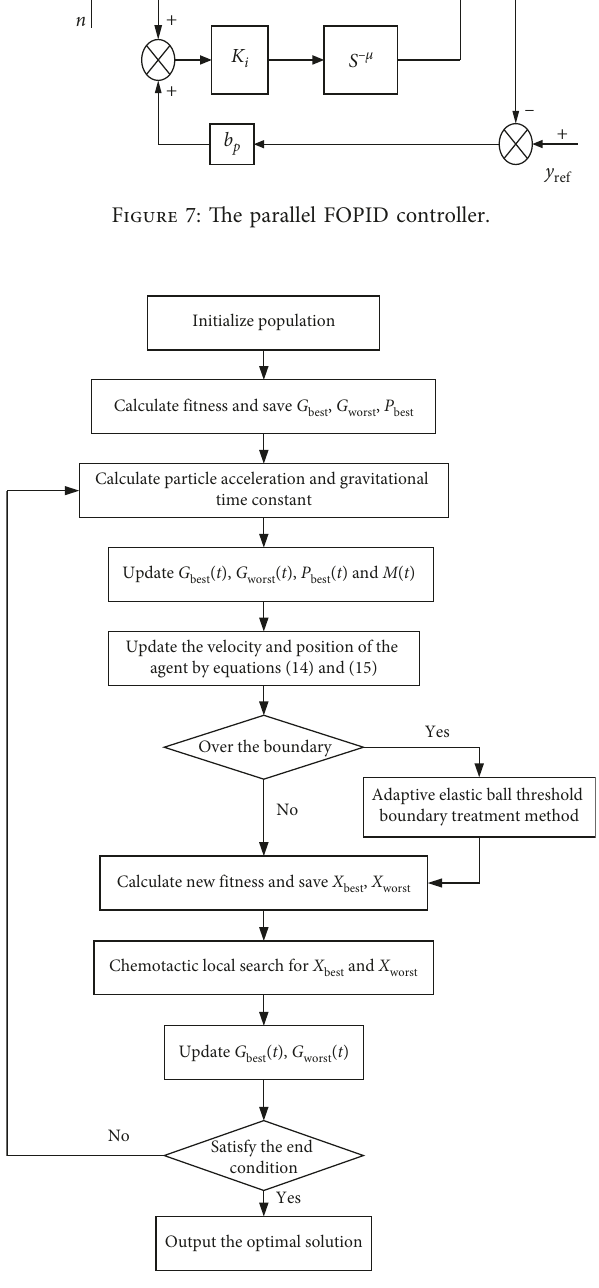
Figure 8: BCGSA optimization